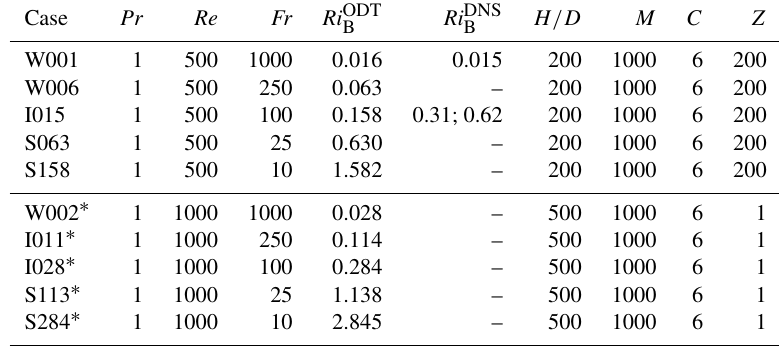
Table 3. Overview of the transient stratified cases simulated with ODT. Case Pr